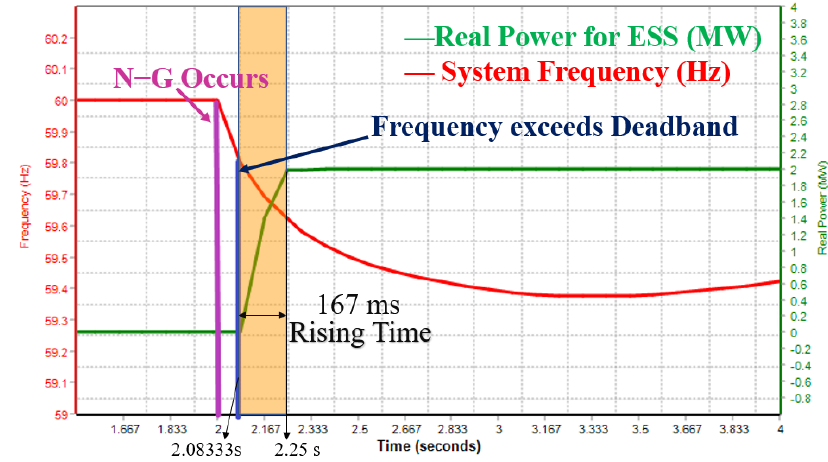
Figure 4. ESS1 real power output and grid frequency when N-1 contingency occurs.